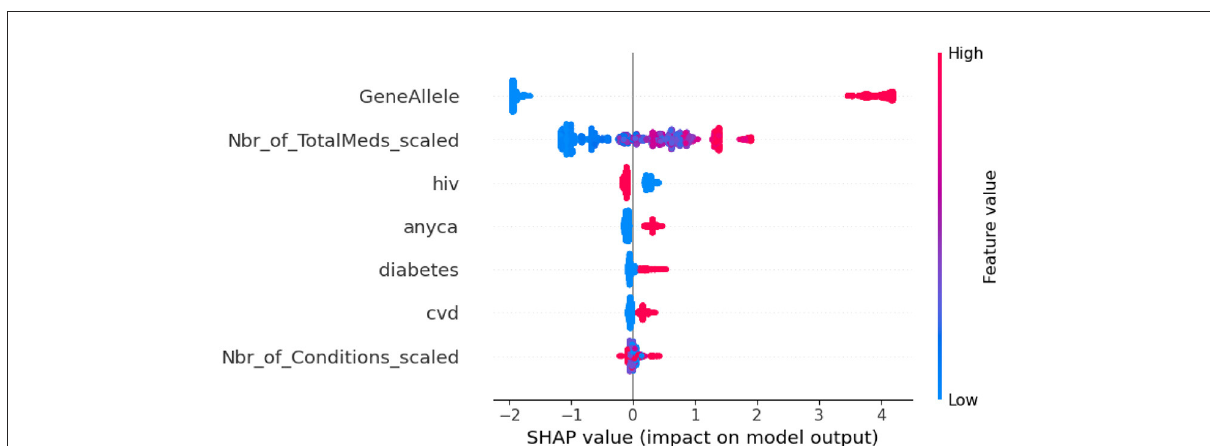
FIGURE7 SHAP values for XGBoost model. GeneAllele = Variable for presence/absence of gene contraindicated with medication, Nbr_of_TotalMeds_scaled = scaled variable for number of total medications, hiv = presence/absence of hiv, diabetes = presence/absence of diabetes, cvd = presence/absence of cardiovascular disease, anyca = presence/absence of cancer, Nbr_of_Conditions_scaled = number of total disease